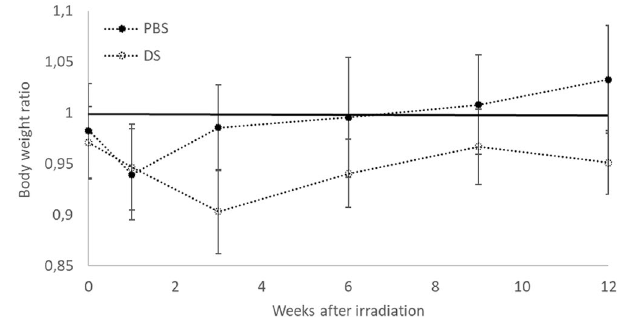
Figure 2. Mouse body weight ratio after PBS or DS 3 months after irradiation. Weight ratio was calculated as follows: irradiated mouse body weight divided by unirradiated mouse body weight. N = 9 in each group. Error bars represent standard error of the mean